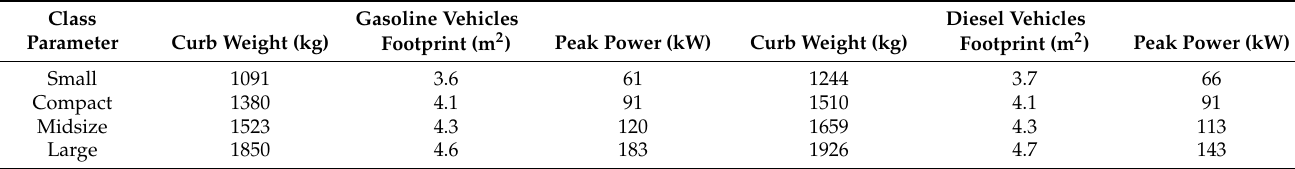
Table 3. Parameters of baseline